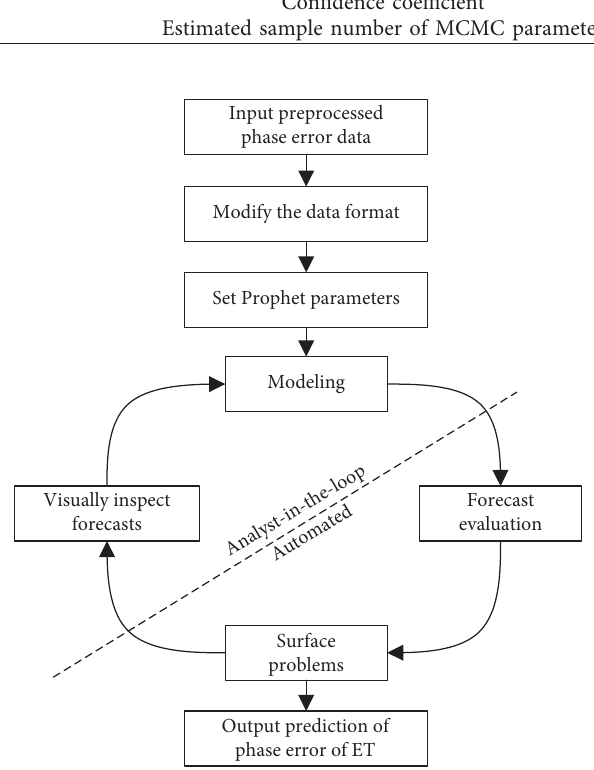
Figure 8: Flowchart of Prophet model prediction.